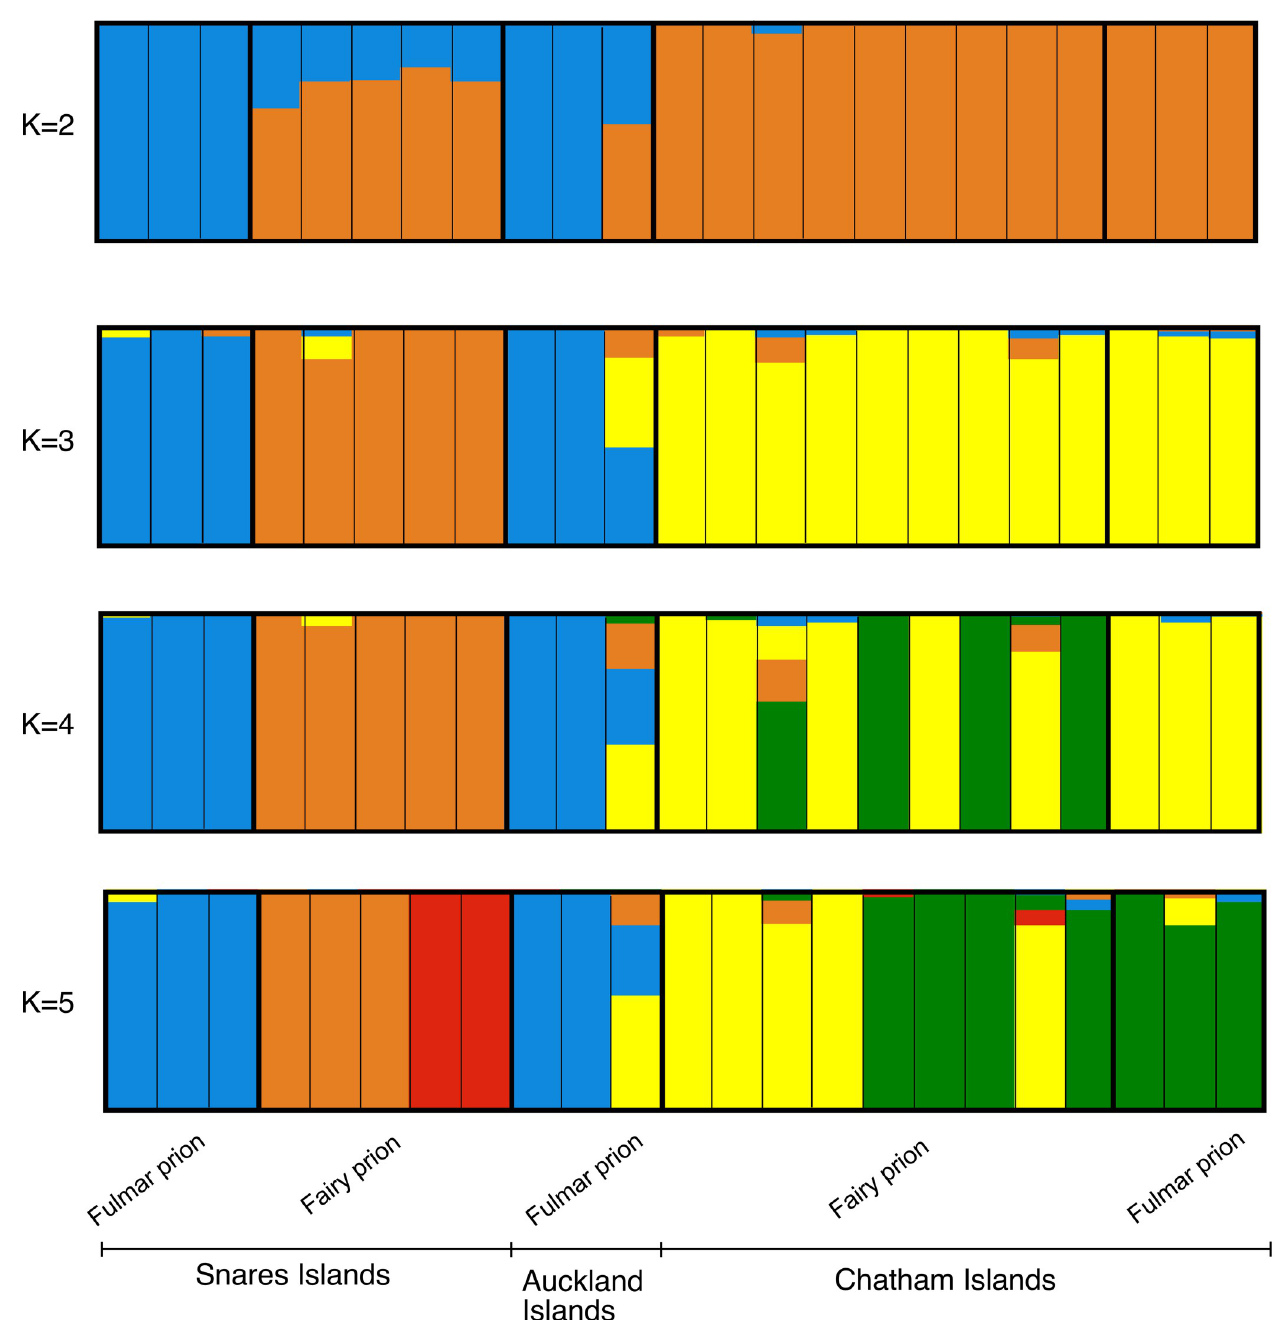
Fig 8. Population structuring determined by sNMF analysis for fairy and fulmar prions ddRADseq SNPs for K = 2 to K = 5.